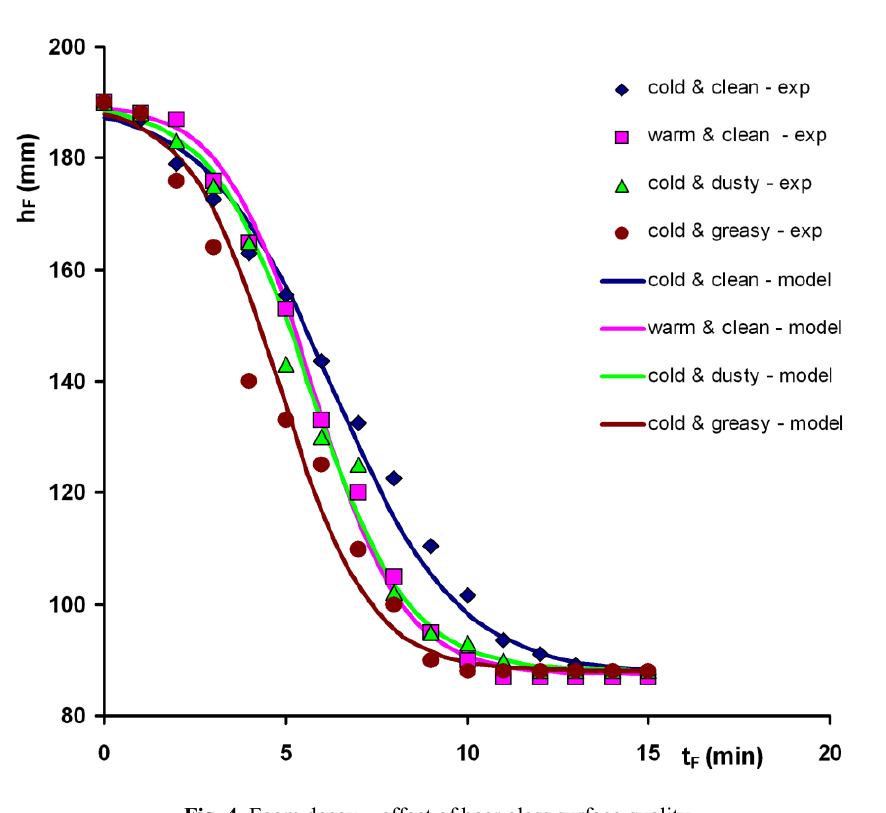
Fig. 4. Foam decay – effect of beer glass surface quality.